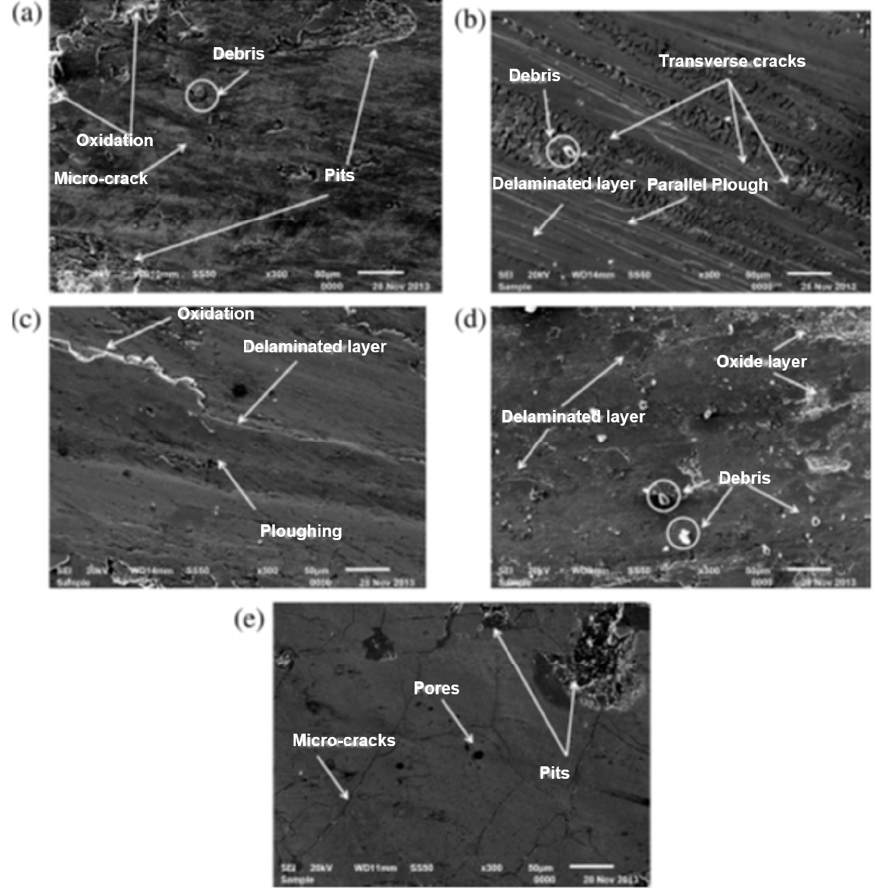
Debris Figure 23. Coated alloy after wear at ( a ) room temperature, ( b ) 100 °C, ( c ) 200 °C, ( d ) 300 °C, and ( e ) Figure 23. Coated alloy after wear at ( a ) room temperature, ( b ) 100 ◦ C, ( c ) 200 ◦ C, ( d ) 300 ◦ C, and 400 °C [131]. (With kind permission from Elsevier). ( e ) 400 ◦ C [131]. (With kind permission from Pits